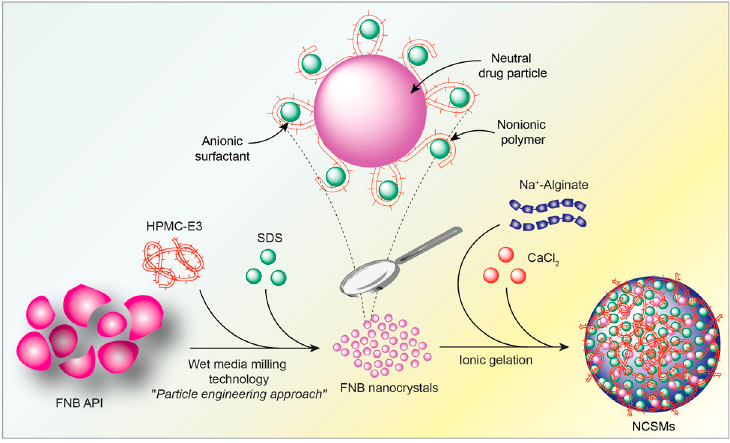
Figure 1. Graphical representation of the production of nanocrystals in composite spherical microparticles (NCSMs) by encapsulation of fenofibrate nanocrystals (FNB-NCs).